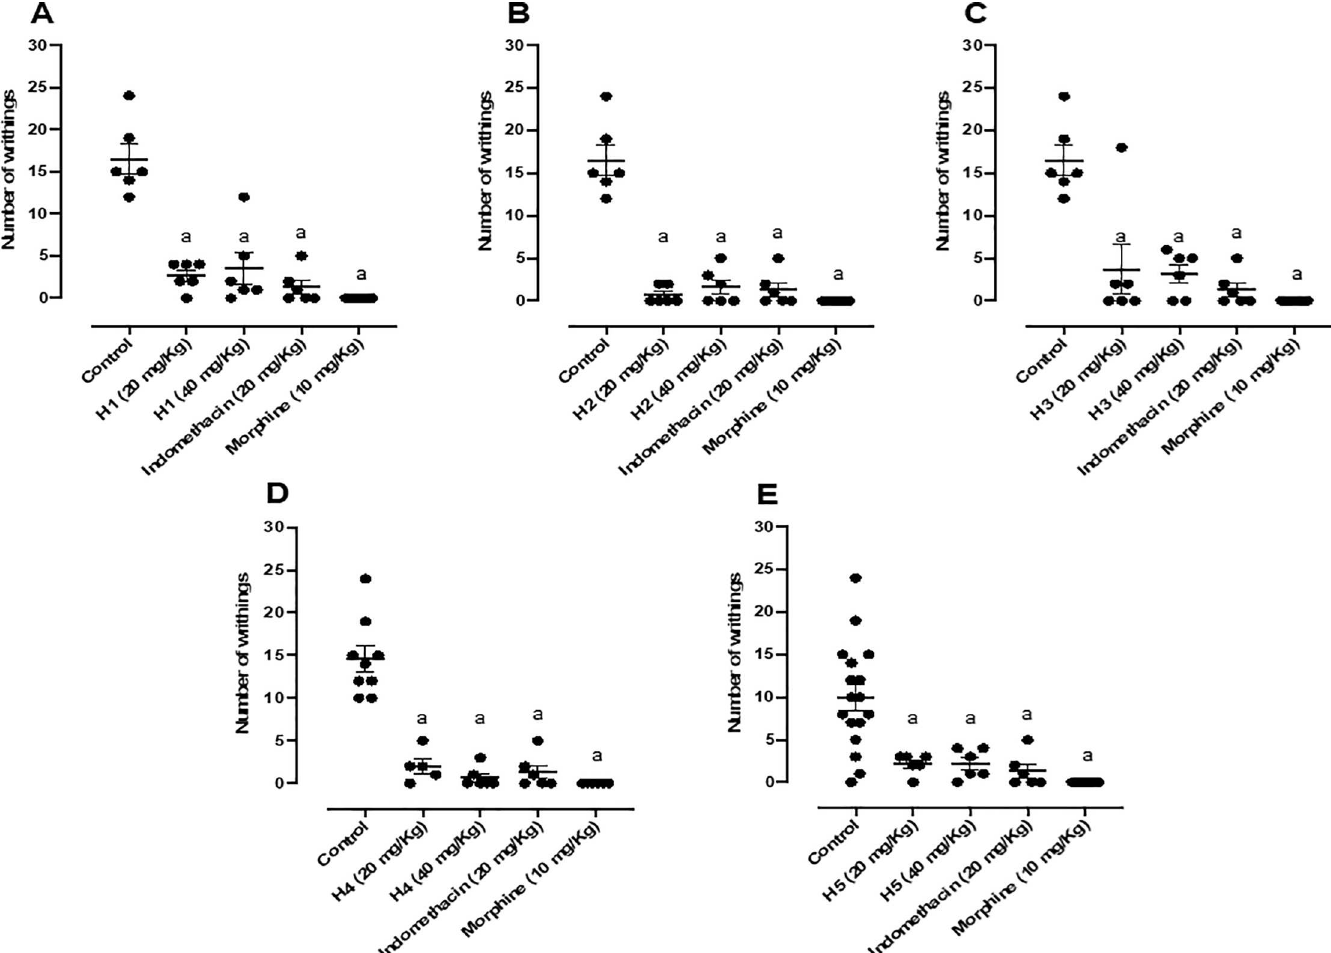
Fig 2. (A) Effect of H1 (20 and 40 mg/kg, p.o.), morphine (10 mg/kg, i.p.) and indomethacin (20 mg/kg, i.p.); (B) Effect of H2 (20 and 40 mg/kg, p.o.), morphine (10 mg/kg, i.p.), and indomethacin (20 mg/kg, i.p.); (C) Effect of H3 (20 and 40 mg/kg, p.o.), morphine (10 mg/kg, i.p.) and indomethacin (20 mg/kg, i.p.); (D) Effect of H4 (20 and 40 mg/kg, p.o.), morphine (10 mg/kg, i.p.) and indomethacin (20 mg/kg, i.p.); (E) Effect of H5 (20 and 40 mg/kg, p.o.), morphine (10 mg/kg, i.p.) and indomethacin (20 mg/kg, i.p.) in the acetic acid-induced writhing test in mice (n = 6, per group). Values are expressed as the mean ± SEM, where a indicates p < 0.05, significantly different from the control group, according to ANOVA, followed by Tukey’s